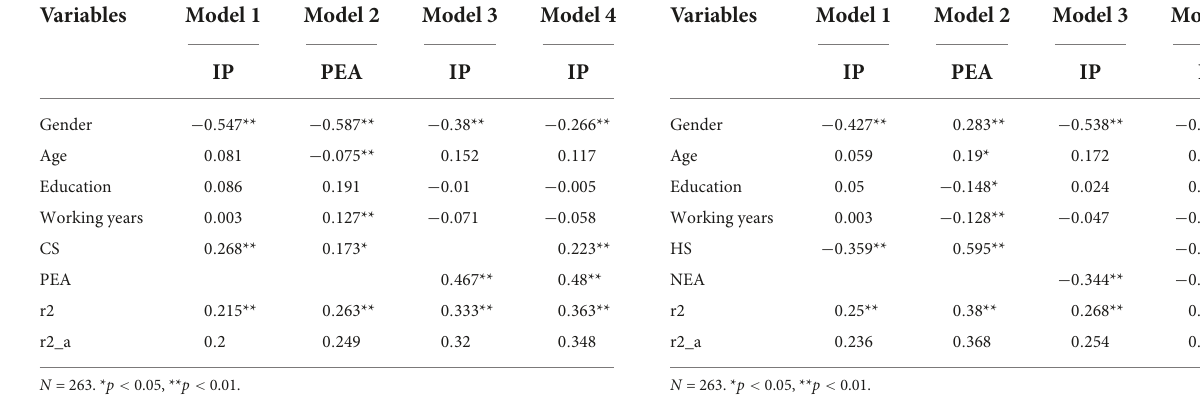
TABLE 4 Results of mediation of negative emotional atmosphere in the relationship between hindrance stressor and innovation